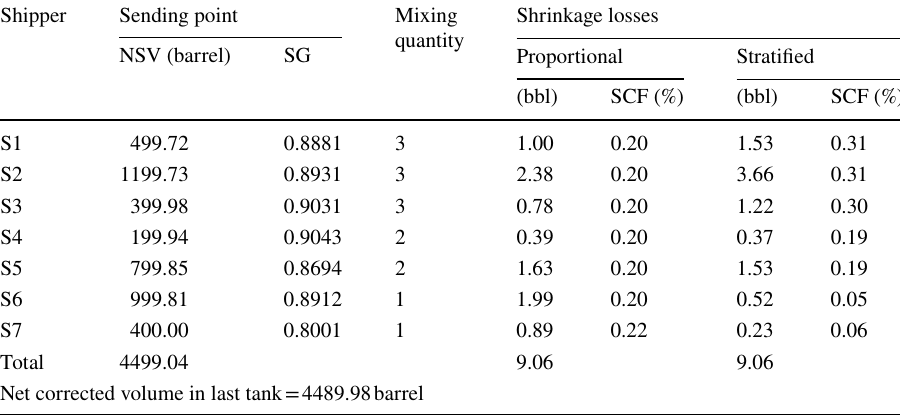
Table 15 Comparison between proportional and stratified